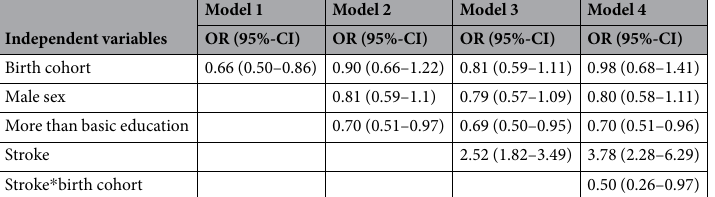
Table 5. Logistic regression analyses regarding the association between the dependent variable dementia and the independent variables birth cohort, sex, education and stroke, and different interaction terms. Dementia